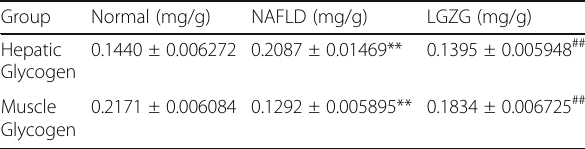
Table 2 Ling-gui-zhu-gan decoction reduces hepatic